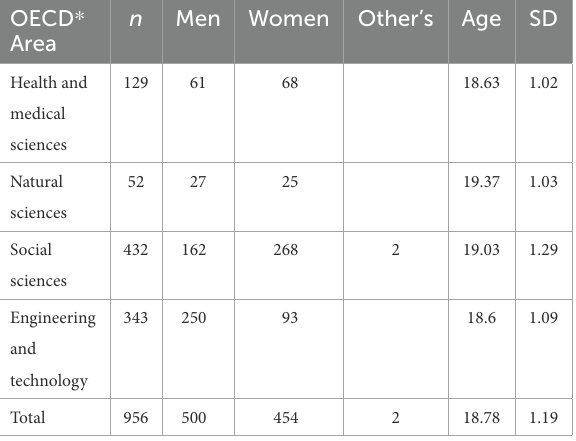
TABLE 1 Description of participants according to area of knowledge, sex, and age. OECD *